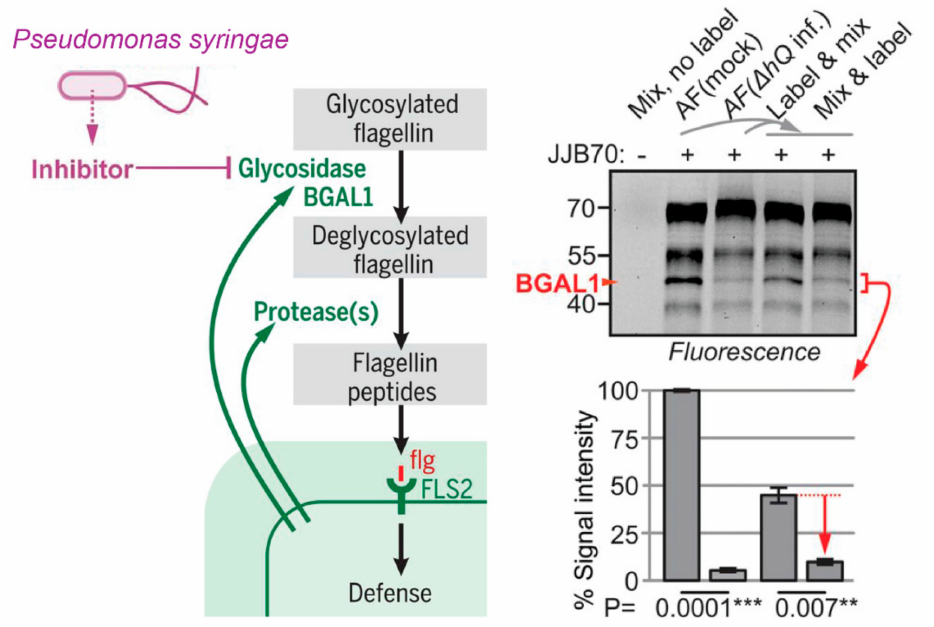
Figure 5. Secreted β -galactosidase BGAL1 and proteases contribute to plant host immunity against bacteria with glycosylated flagellin. Secretion of a BGAL1 inhibitor by pathogenic P. syringae sup- presses host defense response. BGAL1 labeling is suppressed in apoplastic fluid (AF) of infected plants at 2 days postinfection (dpi). The two samples were also mixed in a 1:1 ratio before (mix and label) and after (label and mix) labeling with JJB70. The quantified fluorescence of the BGAL1 signal is plotted below. Error bars indicate mean ± SE of n = 3 replicates; t test was used to determine P values [44]; *** and ** indicate p values < 0.001 and 0.01, respectively. Image and caption